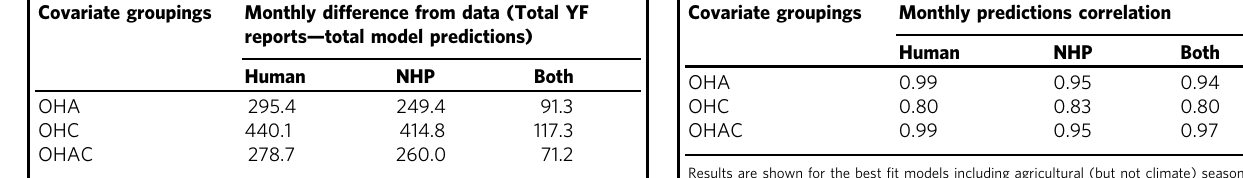
Table 2 Absolute total deviances between YF reports and within-sample model predictions (for models fi tted to all the data) by covariate grouping.